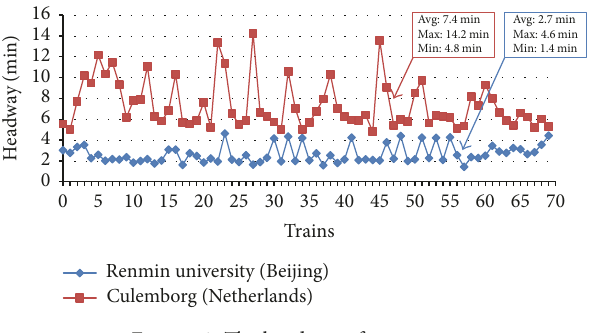
Figure 9: The headway of two